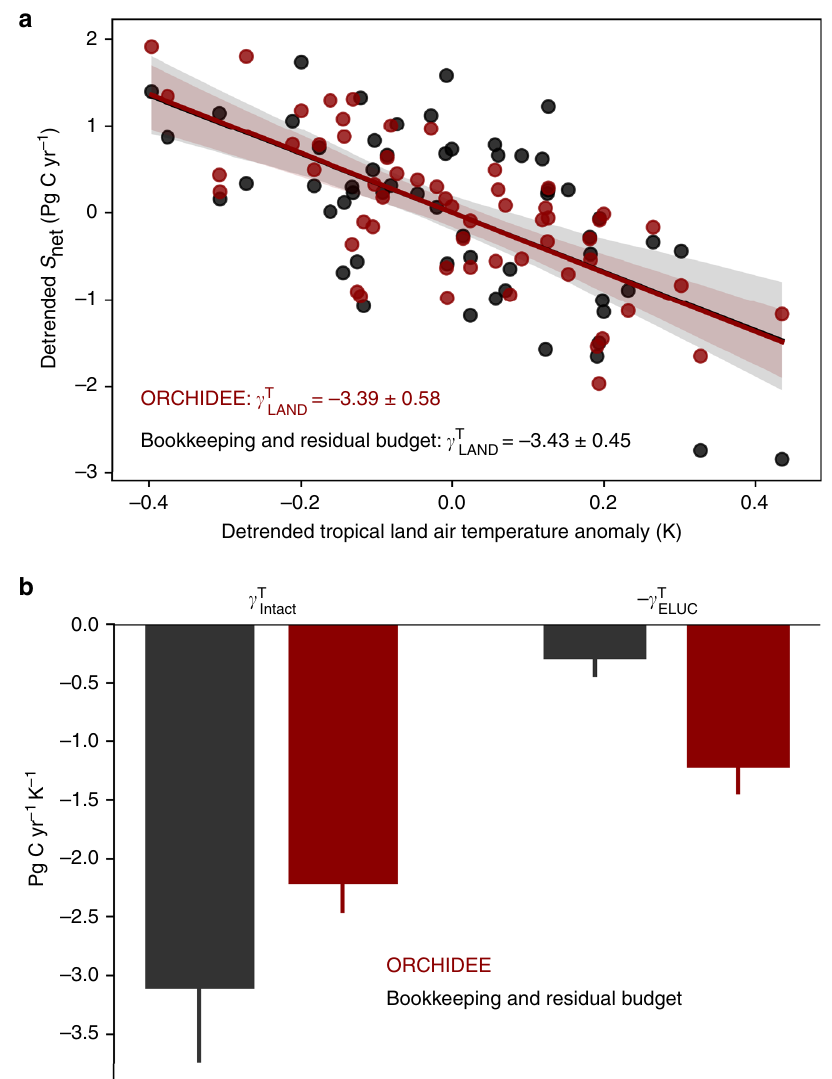
Fig. 7 Temperature sensitivity ( γ ) of S net , S Intact , and E LUC . Red color indicates results from ORCHIDEE. Black color indicates results for the bookkeeping and residual budget approach (i.e., IPCC AR5 and ref. 14 ). a The temperature sensitivities of S net ( γ T ). b The decomposition of γ T into γ T and LAND LAND Intact (cid:1) γ T , following the equation “ S net = S Intact − E LUC ” . Negative values of γ T and γ T mean that elevated tropical land warming leads to less land ELUC LAND Intact carbon uptake, while positive values of γ T mean that warming leads to enhanced carbon emissions from managed land (note that (cid:1) γ T is shown in ELUC ELUC the fi gure). All linear regressions were signi fi cant with a p < 0.05 ( n = 57, two-sided p -value). Shaded area in subplot a indicates the 95% con fi dence interval of fi tted values. Error bars in subplot b indicate the standard error of fi tted γ